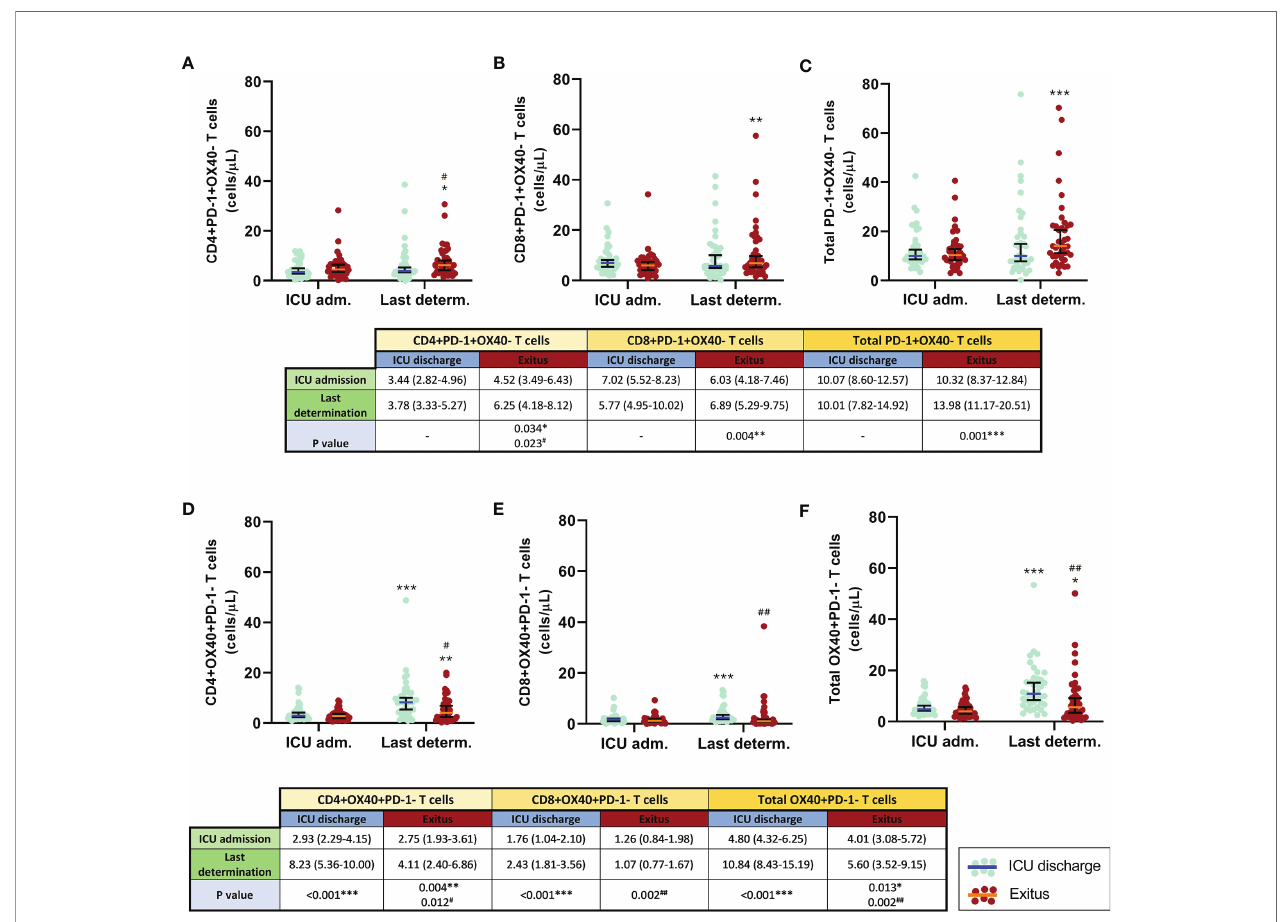
FIGURE 4 | Comparison of the circulating exhausted (PD-1 + OX40 − ) and activated (OX40 + PD-1 − ) T cells in discharged ( blue ) and deceased ( red ) coronavirus disease 2019 (COVID-19) patients between the fi rst and the last determination in the ICU. (A) CD4 + PD-1 + OX40 − T cells. (B) CD8 + PD-1 + OX40 − T cells. (C) Total PD-1 + OX40 − T cells. (D) CD4 + OX40 + PD-1 − T cells. (E) CD8 + OX40 + PD-1 − T cells. (F) Total OX40 + PD-1 − T cells. All data shown are the median and 95% con fi dence intervals of cells per microliter. # p ≤ 0.05m, ## p ≤ 0.01 comparing opposite groups, respectively; * p ≤ 0.05, ** p ≤ 0.01, *** p ≤ 0.001 compared with ICU admission, respectively.